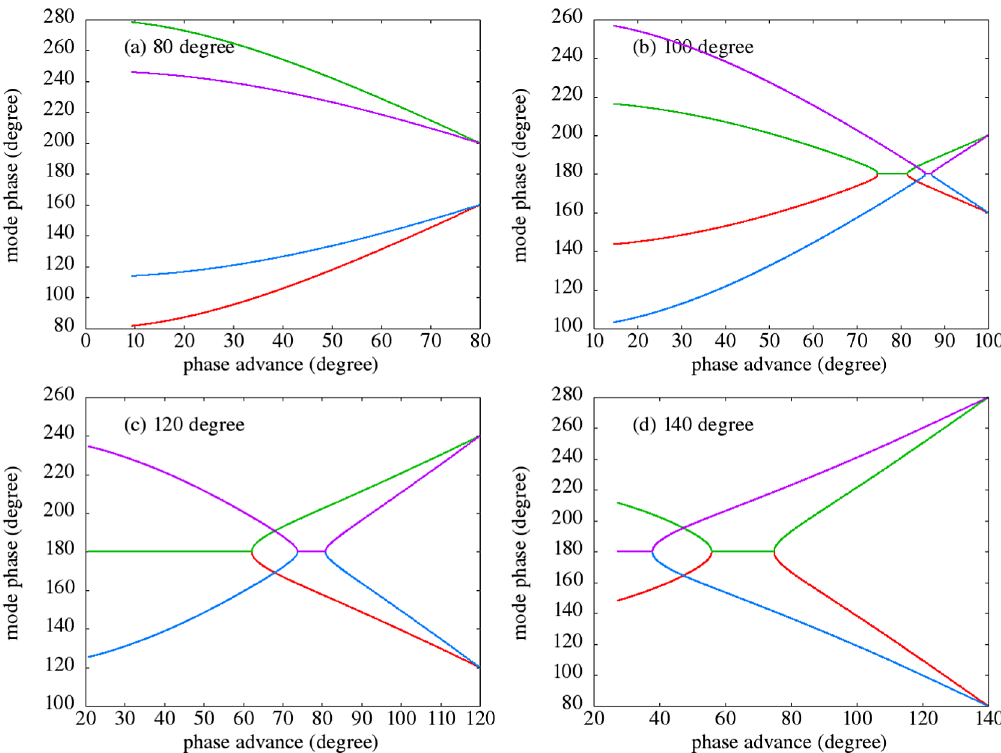
FIG. 5. The 2D envelope mode phases as a function of depressed transverse phase advance for (a) 80 °, (b) 100 °, (c) 120 °, and (d) 140 ° zero current transverse phase advances in a periodic solenoid channel. The four colors are the phases of the four eigenvalues.